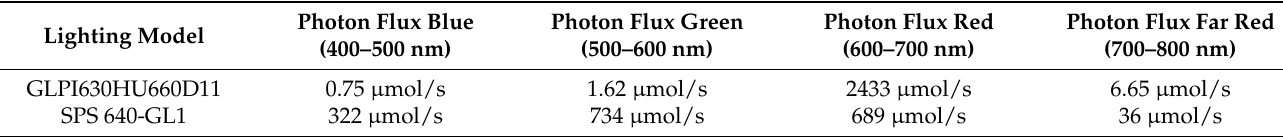
Table A1. Color spectrum of LED lights used in model